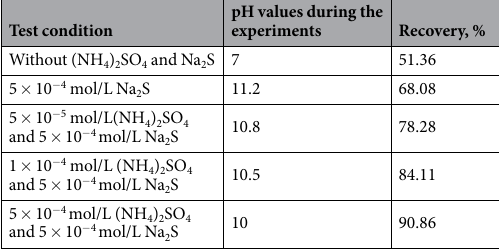
Table 1. Effect of pH on Microflotation of malachite.